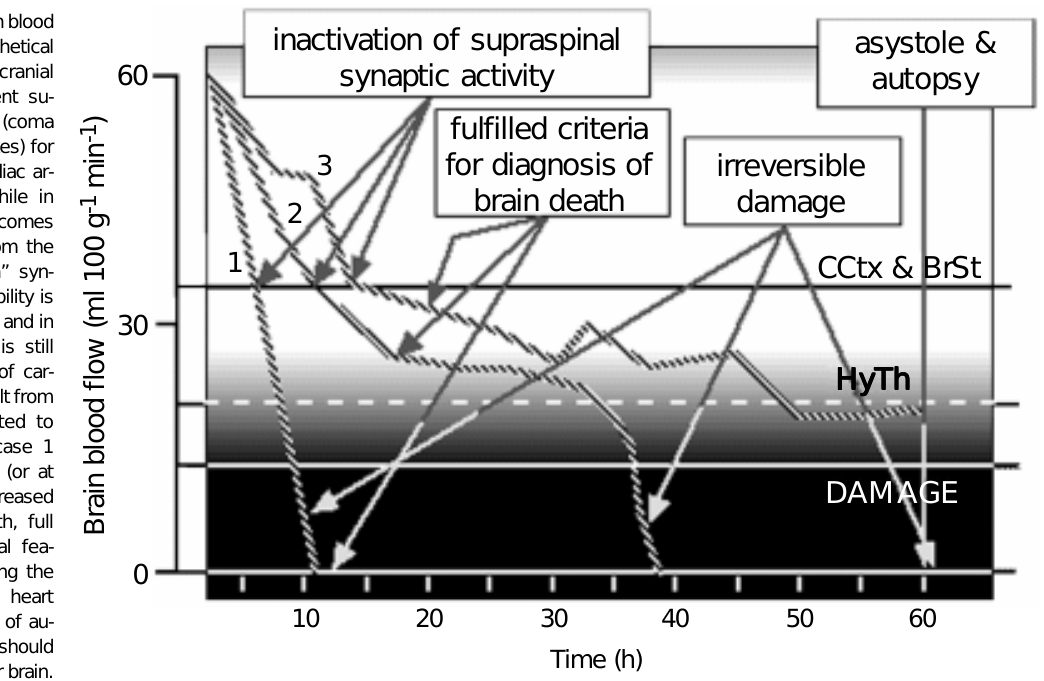
Figure 1 - Evolution of brain blood flow (BBF) in three hypothetical cases of increased intracranial pressure (ICP) with absent su- praspinal synaptic activity (coma and absent cephalic reflexes) for at least 48 h prior to cardiac ar- rest at 60 h-survival. While in case 1 brain damage becomes irreversible within 6 h from the onset of the “brain death” syn- drome, in case 2 irreversibility is only achieved within 24 h, and in case 3 the brain tissue is still recoverable by the time of car- diac arrest which may result from metabolic disorders related to hypothalamic failure. If case 1 was representative of all (or at least most) cases of increased ICP at risk of brain death, full maturation of pathological fea- tures would develop during the next 48 h of continuous heart beating, and nearly 100% of au- topsies (if not all of them) should demonstrate the respirator brain. In contrast, since respirator brain is only seen in 40% of these cases (21), global ischemic penumbra of variable duration is to be alternatively considered. CCtx & BrSt = BBF threshold below which cerebral cortex and brain stem functions become inactive (35 ml 100 g -1 min -1 ); DAMAGE = BBF threshold below which cells depolarize (10-15 ml 100 g -1 min -1 ). HyTh = BBF threshold below which hypothalamic secretory functions become inactive (CCtx & BrSt > HyTh >